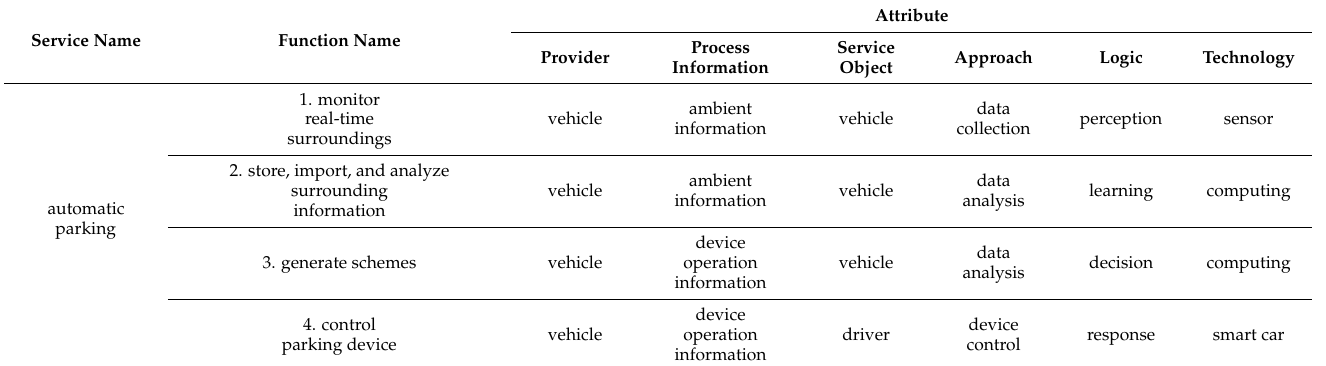
Table 1. Examples of function text data.